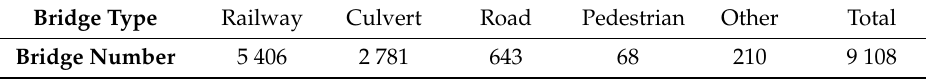
Table 8. Bridge stock of the ÖBB in 2016, arranged according to their general function.